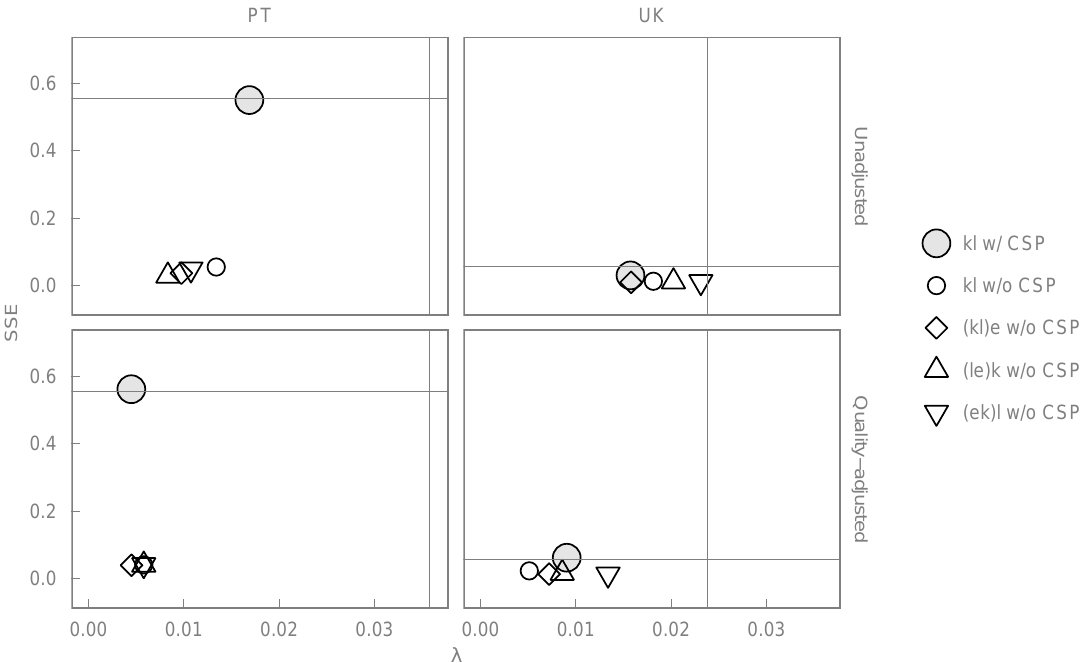
Figure 5. Sum of squared errors (SSE) and Solow residual ( λ ) for all models. Vertical and horizontal grid lines show λ and SSE, respectively, for the reference model (Equation (5)). See Appendix C.1 for tables of SSE and λ